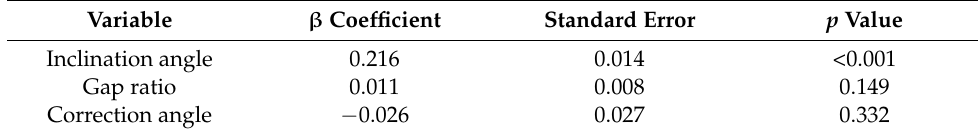
Table 6. Multivariate regression analysis for change in posterior tibial